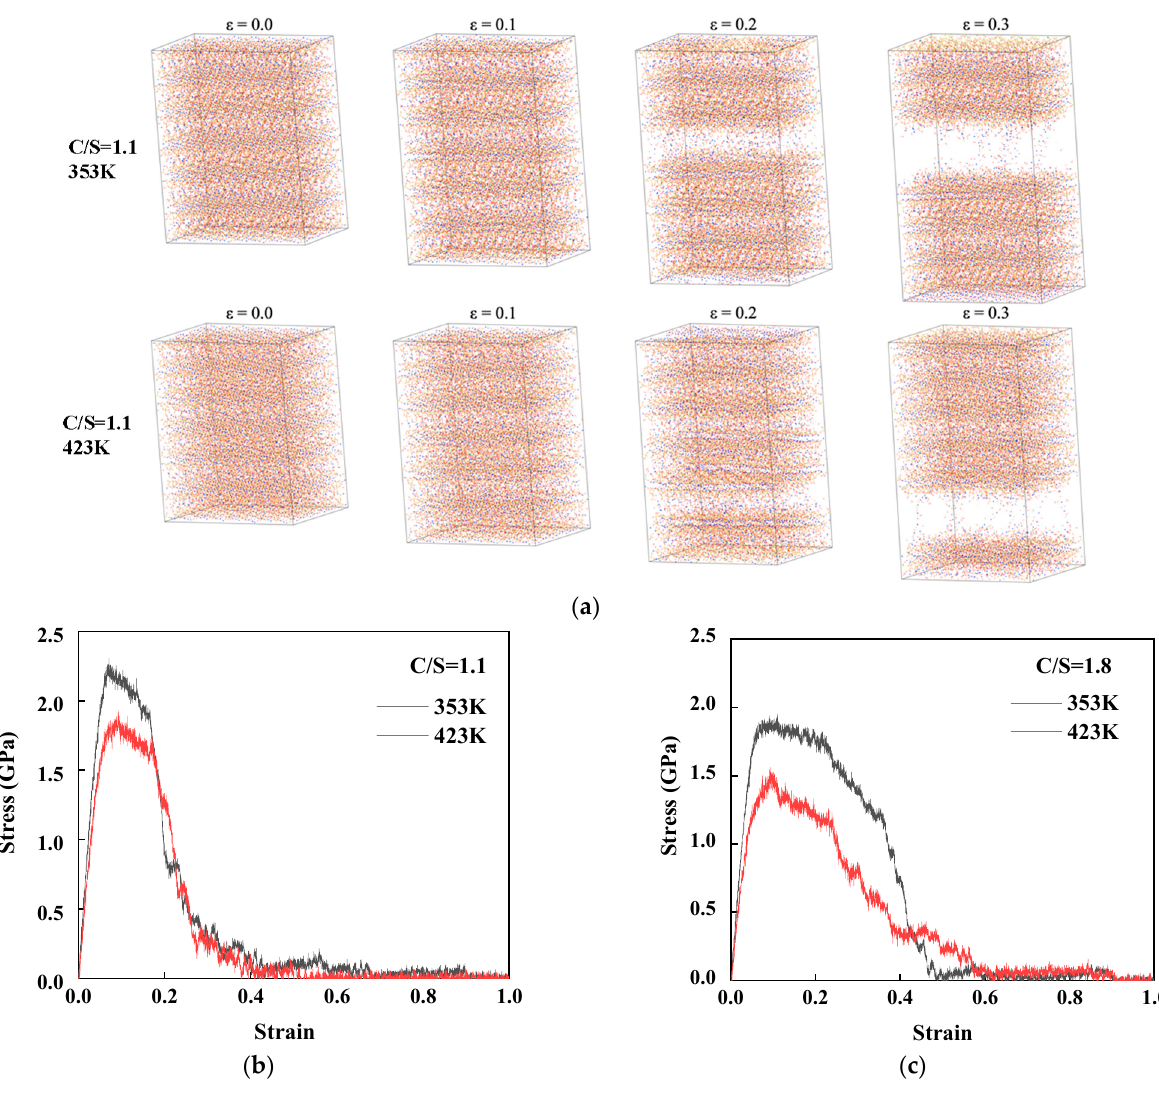
Figure 9. Stress–strain curve of C-S-H during tension with different temperatures and C/S. ( a ) Development of the model in tension process with C/S = 1.1 at different temperatures; ( b ) stress–strain curve with C/S = 1.1; ( c ) stress–strain curve with C/S = 1.8.